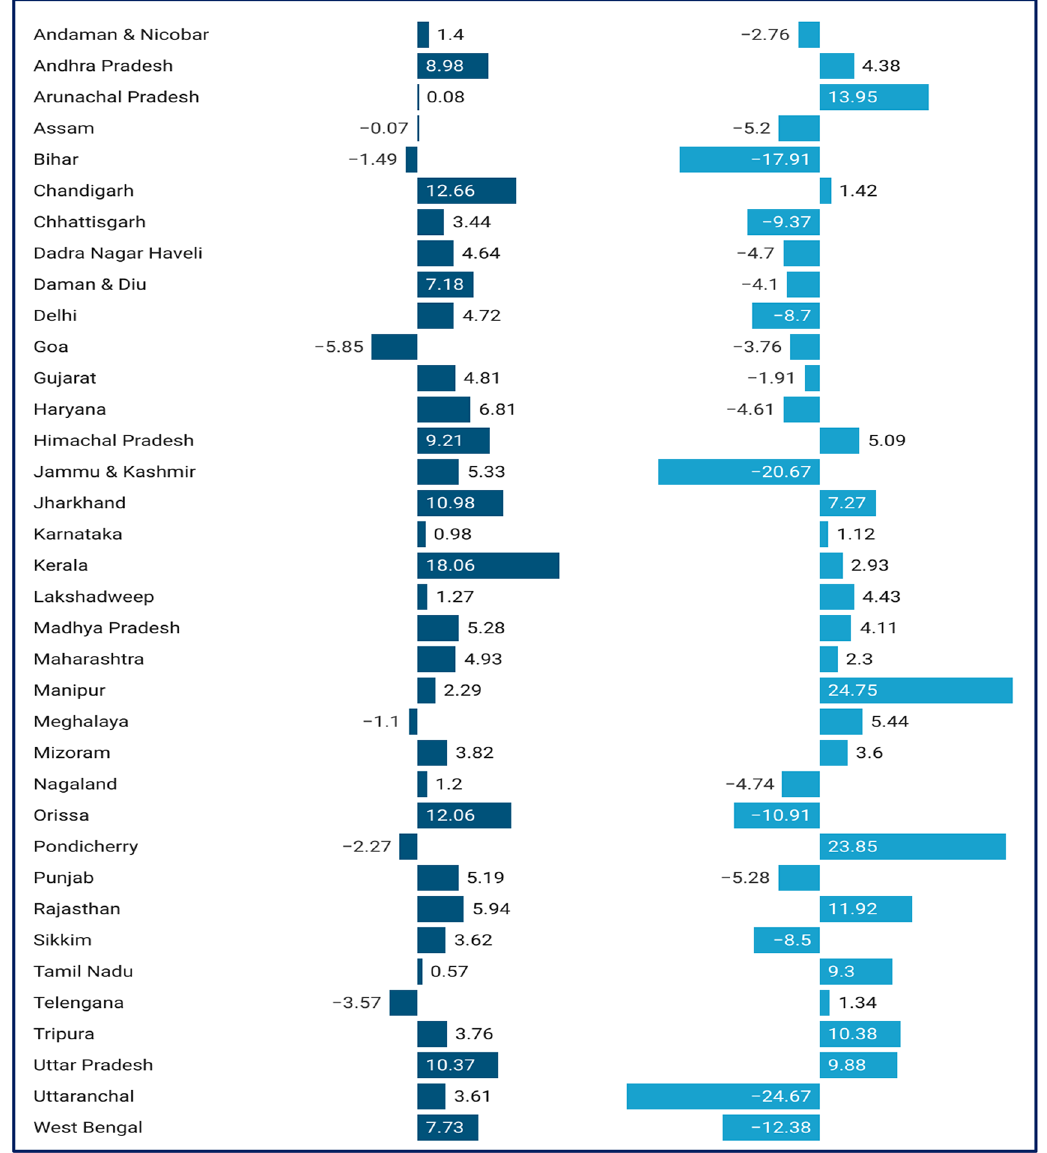
Figure 4. Change in incidence and intensity of CHE by states: